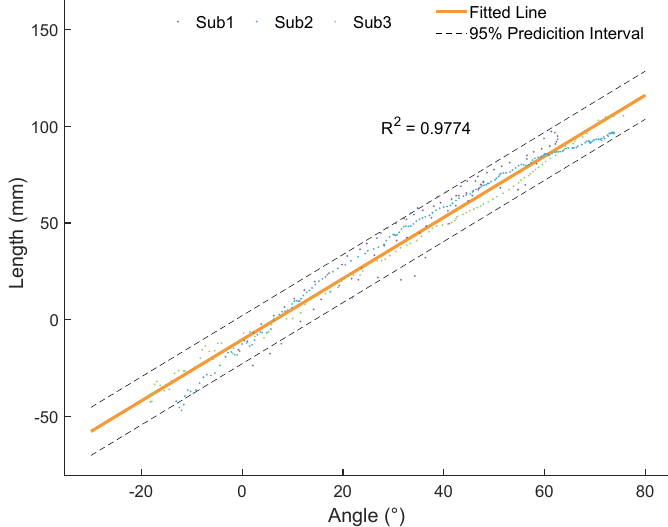
Figure 2. The stiffness model of the soft exosuit. The stiffness model represents the relationship between the angle of hip joint and the length of Bowden cable. The angle of 0 is the angle of hip joint when standing. The positive and negative angles represent the hip flexion and hip extension respectively. The R 2 is the coefficient of